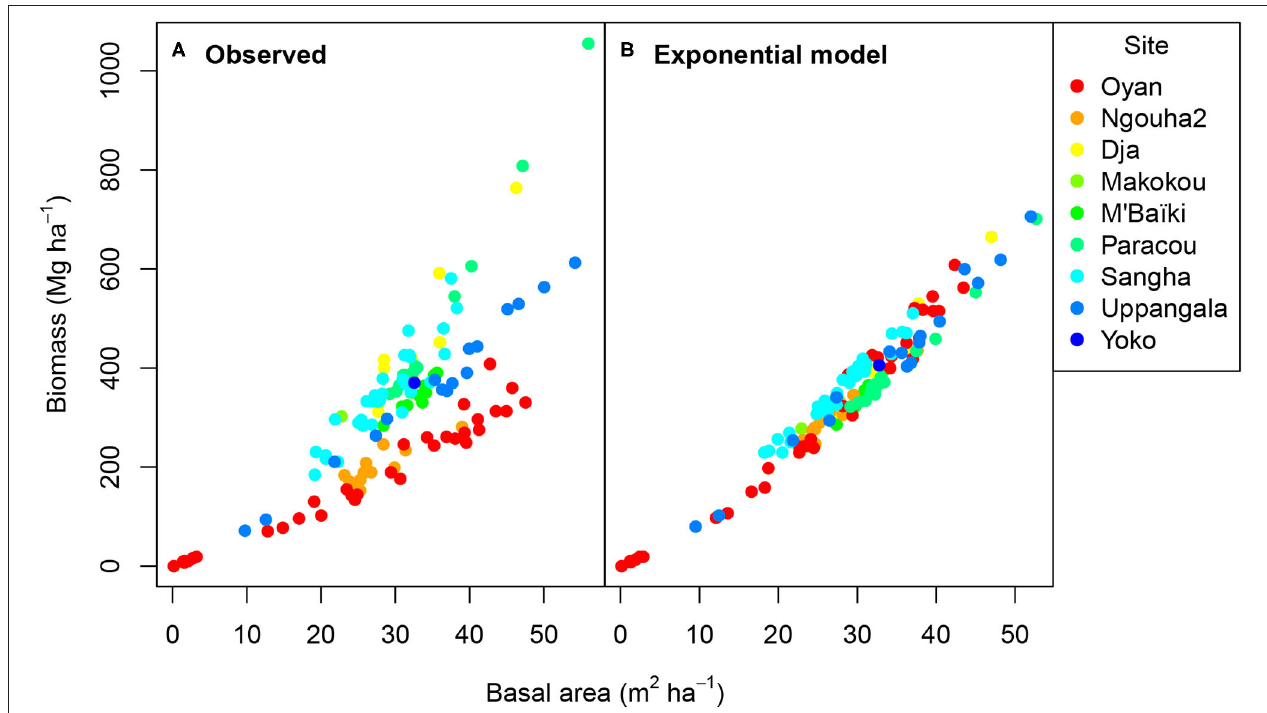
FIGURE 3 | Aboveground biomass vs. basal area for 133 forest stands at nine sites as (A) observed and (B) predicted by the exponential null model. The different colors correspond to the different sites as shown in the